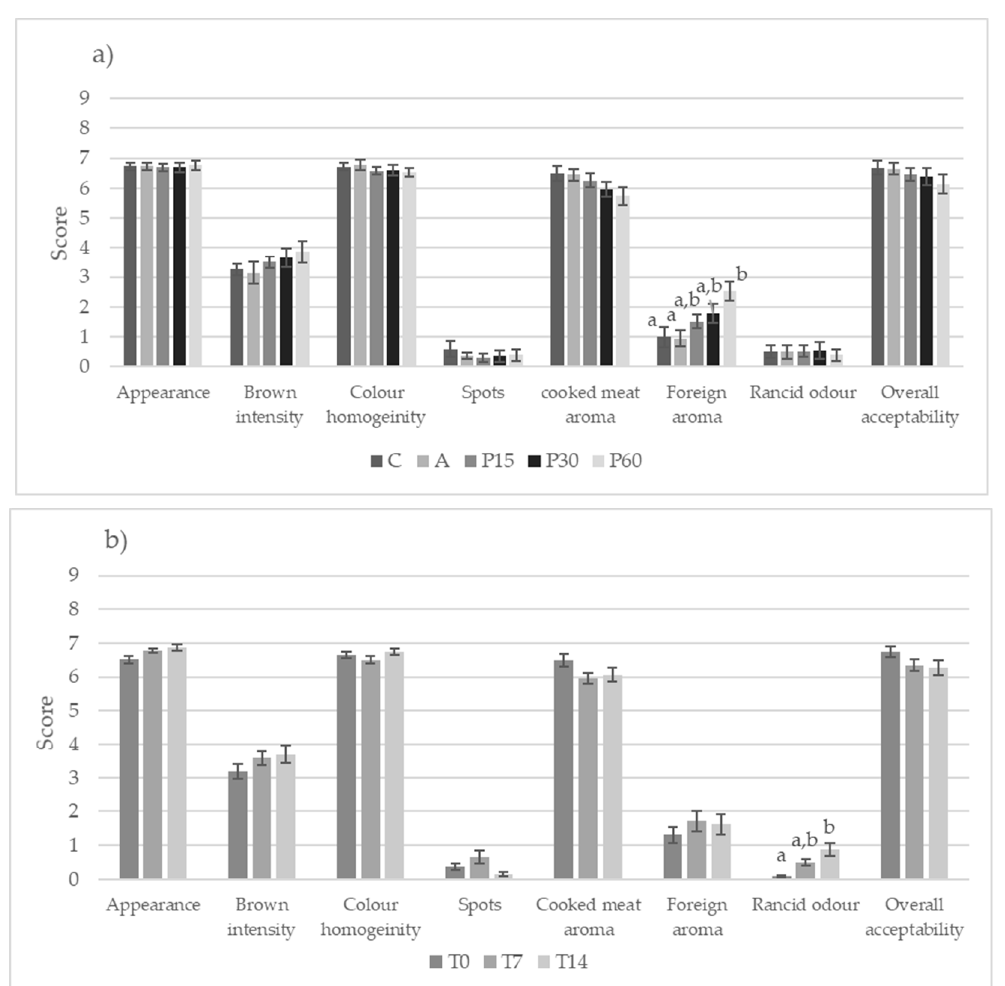
Figure 2. Sensory properties (appearance, brown color intensity, color homogeneity, presence of spots, intensity of cooked meat aroma, presence of foreign aroma, intensity of rancid odor, and overall acceptability) of the cooked burgers related to the formulation ( a ) and storage time ( b ). The results are expressed as estimated marginal means and standard error of the mean of each attribute, scored on a non-structured 0–9 intensity scale. Different letters assigned to each sensory property indicate significant differences (Tukey’s test, p < 0.05). C = negative control, no antioxidant; A = positive control, + 0.05% ascorbic acid; P15 = +0.15% dGCB extract; P30 = +0.30% dGCB extract; P60 = +0.60% dGCB extract. T0 = 0 days of refrigerated storage at 4 ± 1 °C; T7 = 7 days of refrigerated storage at 4 ± 1 °C; T14 = 14 days of refrigerated storage at 4 ± 1 °C.